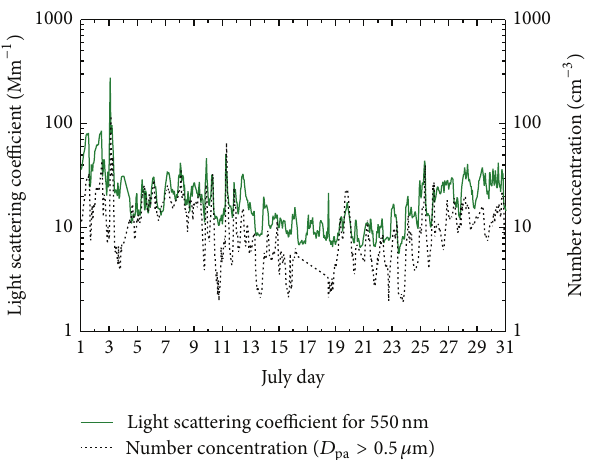
Figure 2: The variations of the light scattering coefficient (at 550 nm) and the particle number concentration ( 𝐷 pa > 0.5 𝜇 m).